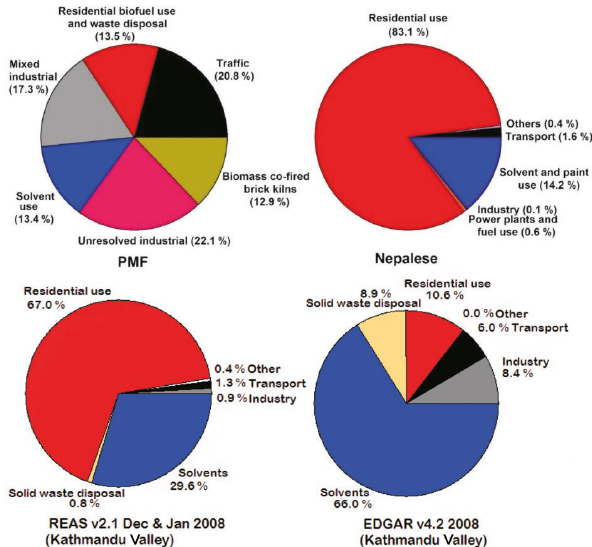
Figure 14. Comparison of the PMF-derived contribution of anthro- pogenic sources with NMVOC source contribution according to the existing Nepalese, REAS and EDGAR emission